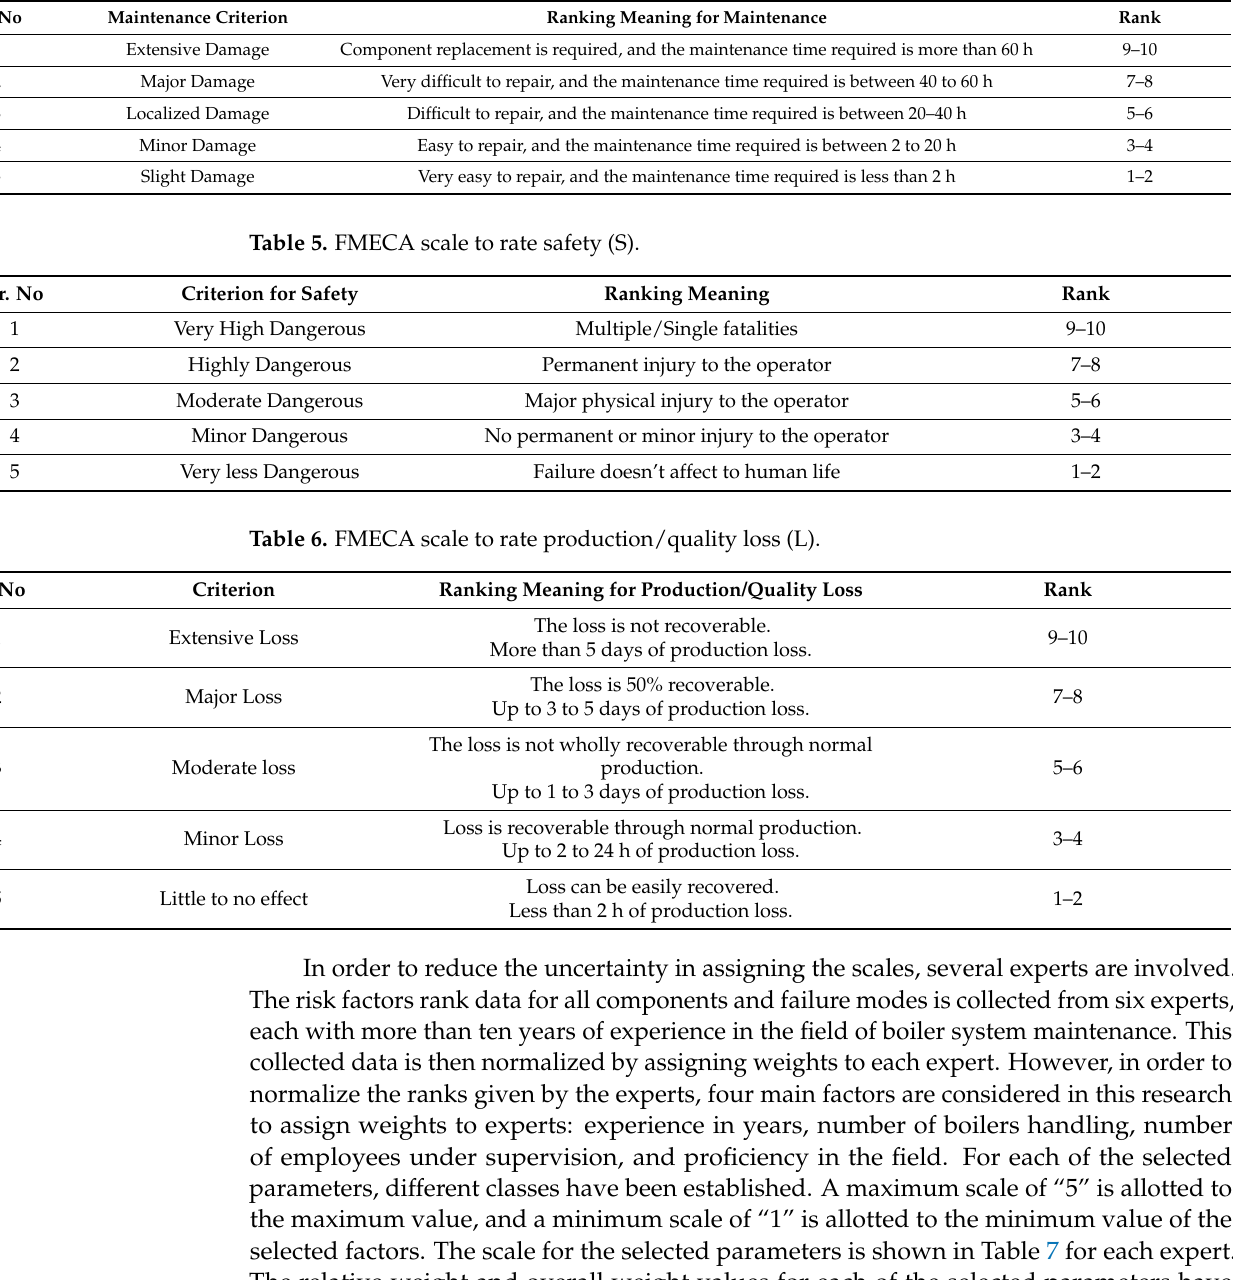
Table 4. FMECA scale to rate maintenance (M).